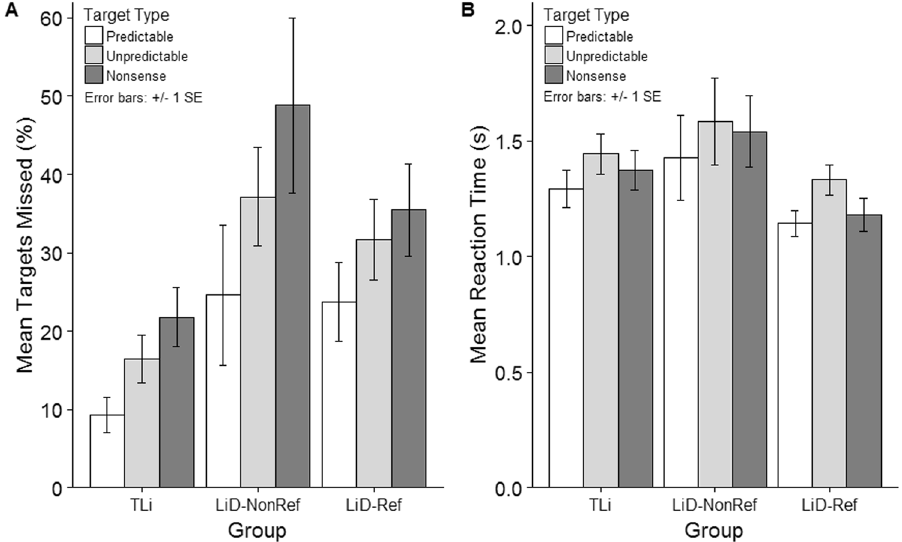
Figure 1. Effect of context on Percentage Targets Missed (panel A) and Reaction Time (seconds) (panel B) for the children with normal listening abilities (TLi) and the children with listening difficulties (Li-Ref; Li-Nonref). Error bars refer to standard